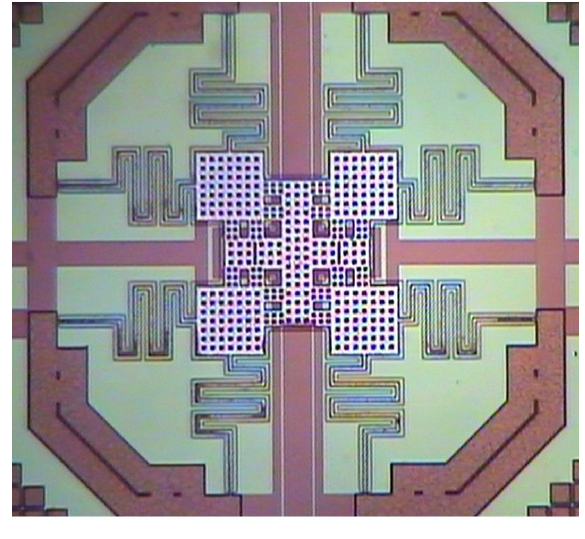
Figure 9. Optical image of the RF switch after the post-process.